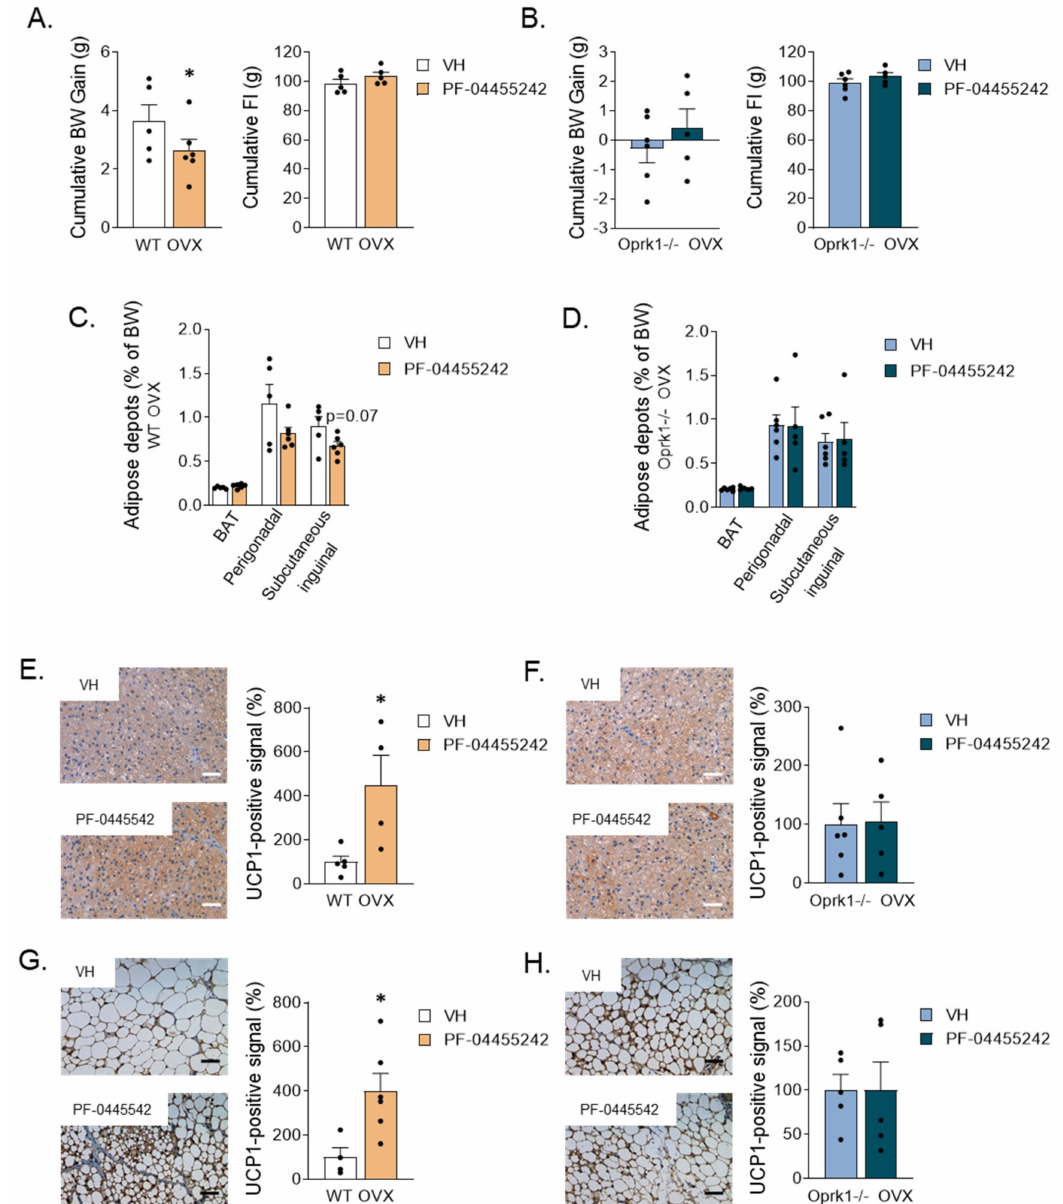
Figure 5. Metabolic effects of the central k-OR antagonist, PF-04455242, or vehicle (VH)